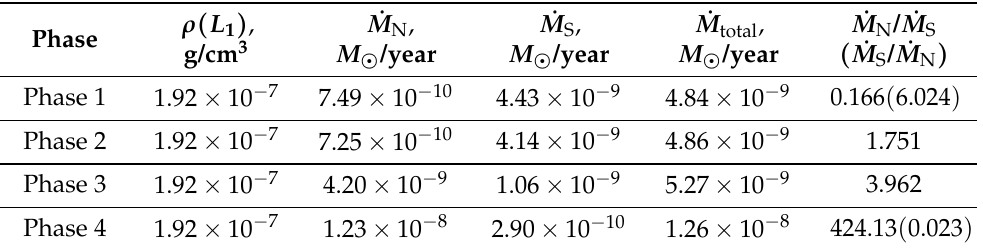
Table 5. Parameters of matter accretion to the white dwarf in the asynchronous polar with the offset dipole for various phases of switching the flow from the south pole to the north